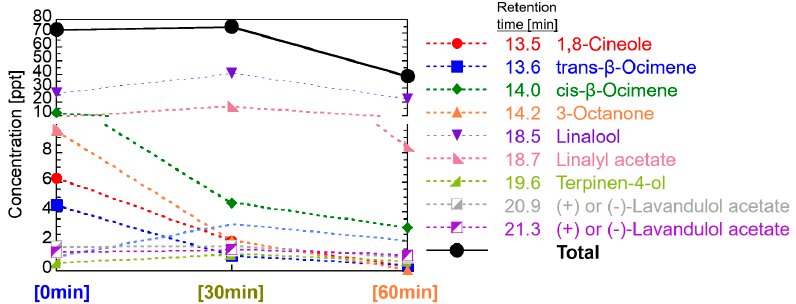
Figure 7. Temporal change of VOCs in the room air diffused by lavender oil.